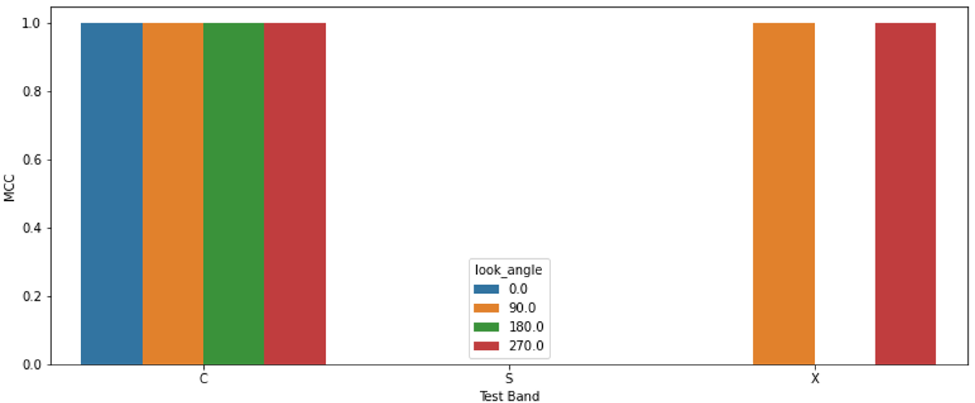
Figure 11. Results for the baseline latent space study. This study is run with four sets of the data using a combination of non-rotated or randomly-rotated images and either normal crop image or circular crop images. All sets have matching results, so only one set is presented. The models trained on C-band performed perfectly for C-band and the 90 ◦ and 270 ◦ look angle X-band images, while it did poorly for S-band and the 0 ◦ and 180 ◦ look angle X-band images. These results confirm the latent space representation of the data has a relation to the model’s performance on that data. The results also convey that latent space is useful regardless of image cropping or applied augmentations. However, cropping and augmentations are consistent between the training and testing images—the only difference is the SAR